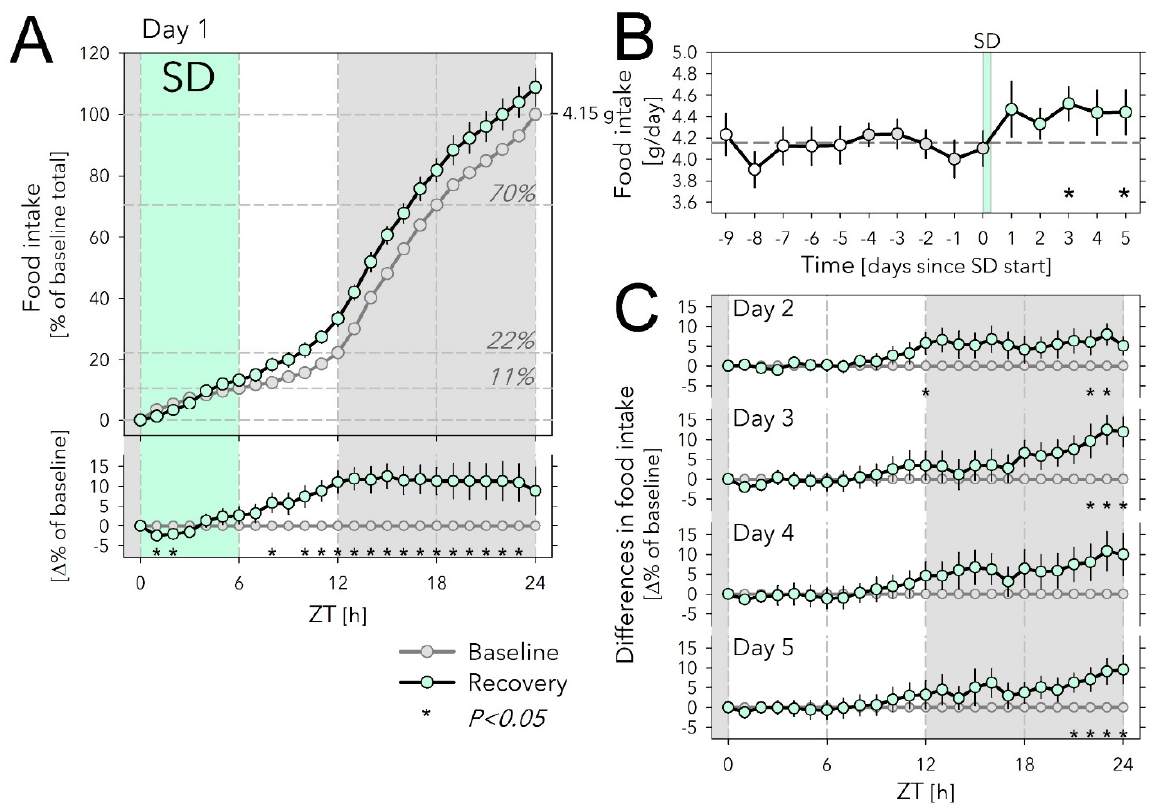
Figure 2. Effects of sleep deprivation on food intake. ( A ) Hourly values of food intake accumulated over 24 h and expressed as % of average daily food intake during the last 5 baseline days (Days − 4 to 0; 100% = 4.15 g) preceding the sleep-deprivation (SD) day (Day 1). Food intake during SD (mint symbols and area) did not differ from baseline (grey symbols, 5-day averages). Horizontal lines in graph indicate % of total daily food eaten at consecutive 6 h intervals during baseline. Lower graph: SD-baseline difference in accumulated food-intake curves depicted in the upper graph. Gray area indicates the 12 h dark period. Asterisks designate hours with significant differences in food intake from baseline (paired two-sided t -tests; p < 0.05; n = 11–17; see Methods for n /day). ( B ) Daily food intake for the 10 days before and the 5 days after the SD. White symbols (Days − 9 to − 5) depict values for 5 additional baseline days recorded in cohort 1 ( n = 6). Please note that these extra baseline days were not included in the analyses. Horizontal dashed line reflects mean over Days − 4 to 0 (=100% in ( A )). SD affected food intake (Days 1 to 5 vs. Days − 4 to 0; two-way ANOVA factor ‘SD’ p = 0.004, ‘Day’ p = 0.89, interaction p = 0.78). Asterisks mark days with significant increase in food intake compared with baseline (average Days − 4 to 0; paired two-sided t -tests; p < 0.05; n = 11–17; see Methods for n /day). ( C ) Recovery-baseline differences in accumulated hourly food-intake values for Days 2 to 5. As on Day 1, the increase in food intake on Day 2 was mainly due to extra food eaten during the 2nd half of the light phase, whereas for Days 3 to 5, extra food intake occurred at the end of the dark phase. Asterisks as in ( A ). Error bars mark ±1 SEM.